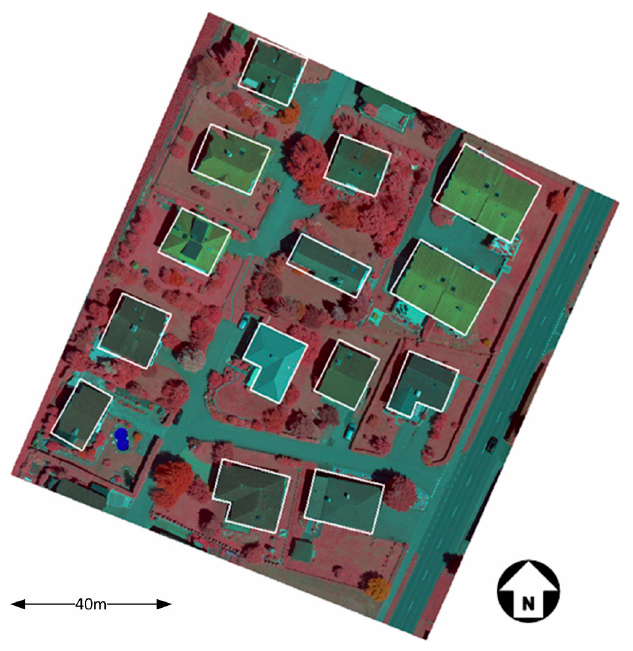
Figure 16. False-color ortho-image together with the enhanced outlines of buildings.